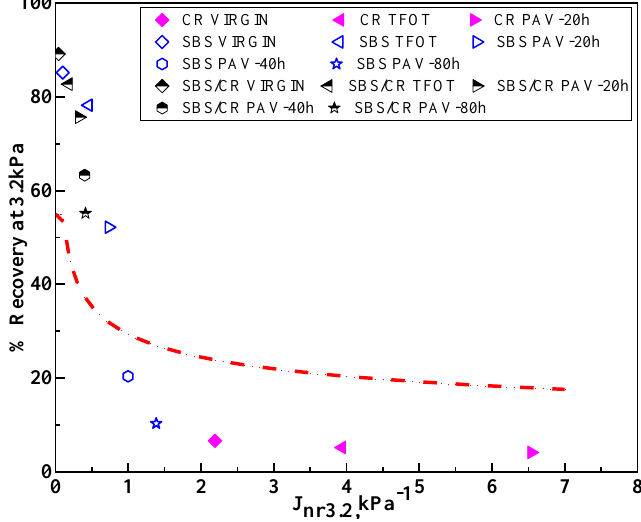
Figure 4. MSCR %R vs. J nr at 3.2 kPa for all tested binders.